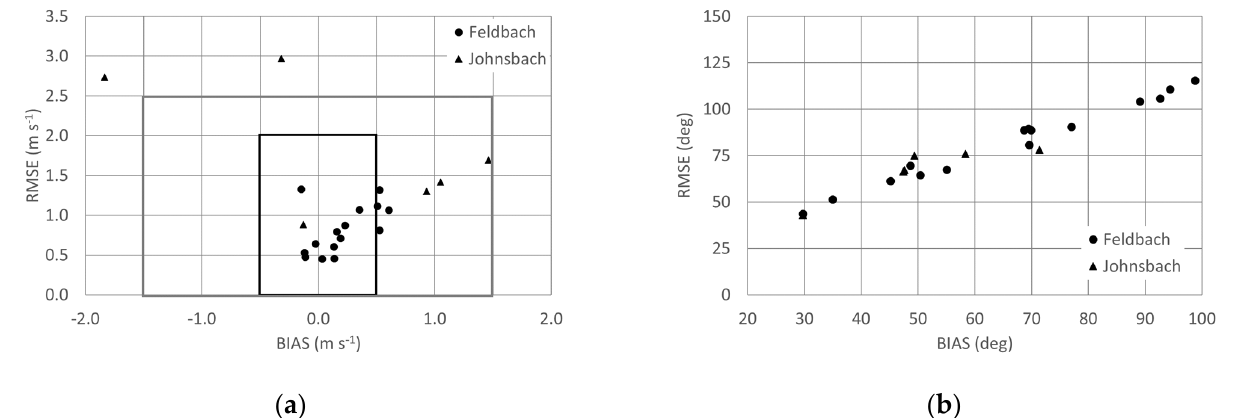
Figure 8. BIAS and RMSE of modelled wind speeds and directions in the Feldbach and Johnsbach domains. The rectangles mark the quality criteria of the European Environmental Agency (EEA) (black) and United States-Environmental Protection Agency (grey) for “complex” conditions.